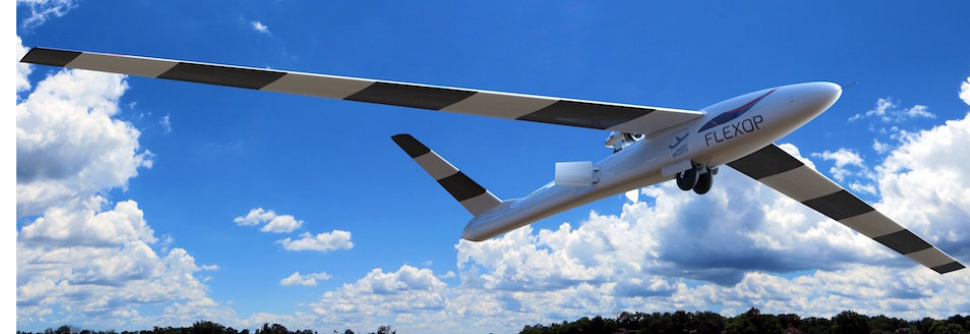
Figure 1. FLEXOP demonstrator aircraft